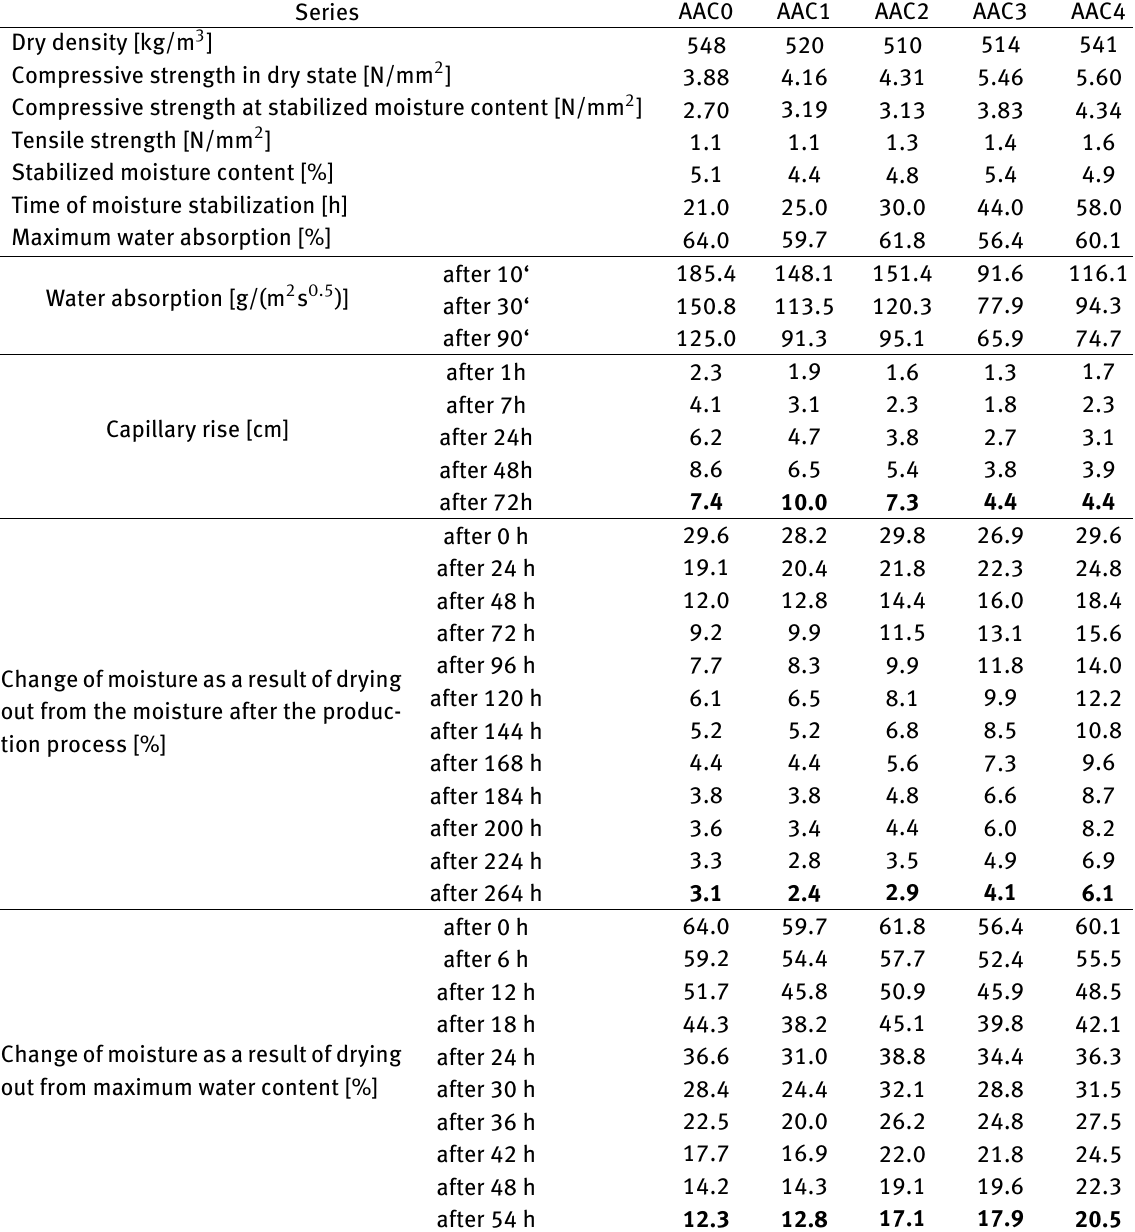
Table 2: Test results of AAC specimens Series AAC0 AAC1 AAC2 Dry density [kg/m 3 ]